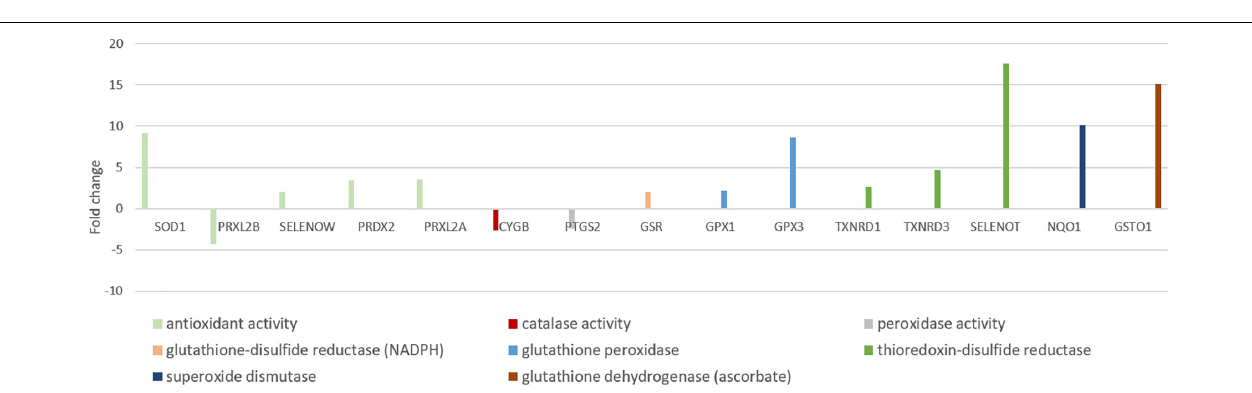
FIGURE 6 | Total number of genes related to aerobic metabolism with a higher (red) and lower expression (blue) in the hooded seal cortical neurons compared to mouse neurons.